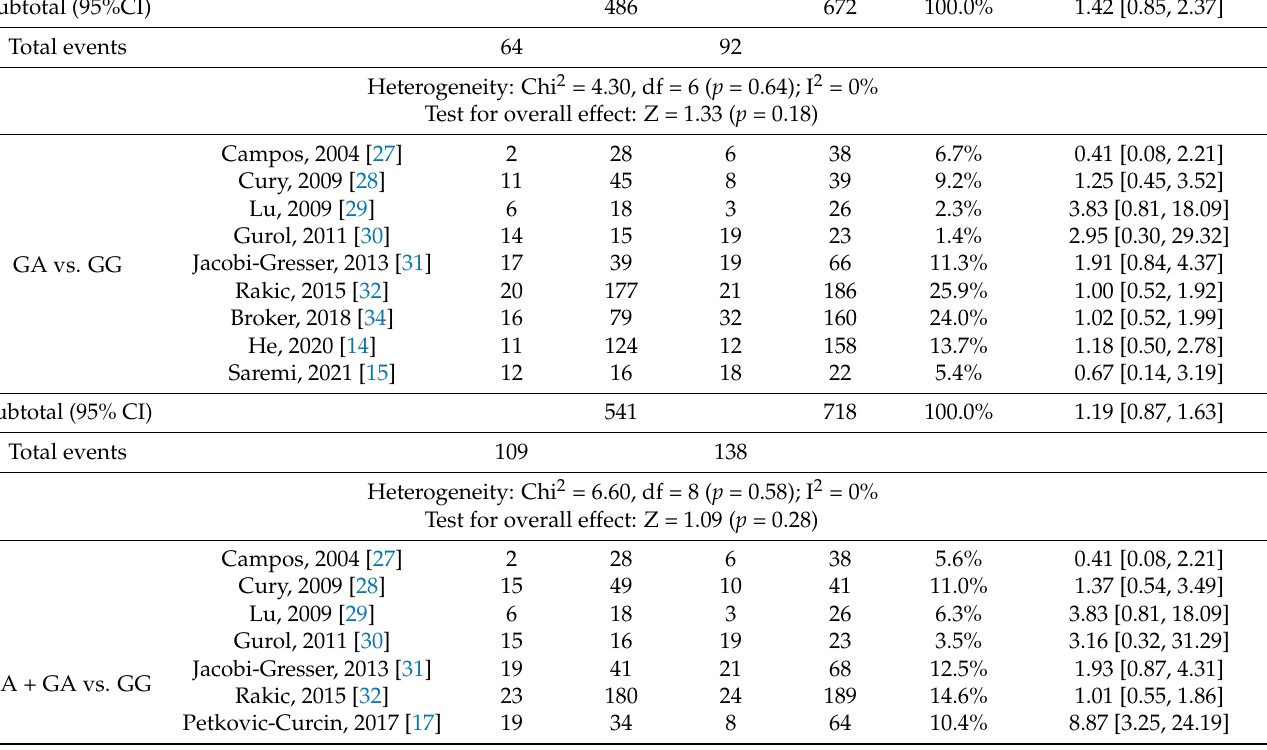
Test for overall effect: Z = 1.33 ( p = 0.18)